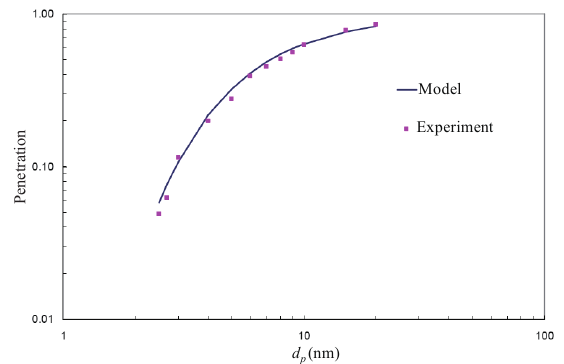
Fig. 5 Penetration vs. particle size. The symbols are experimental results and the solid lines are measured using p computed from the